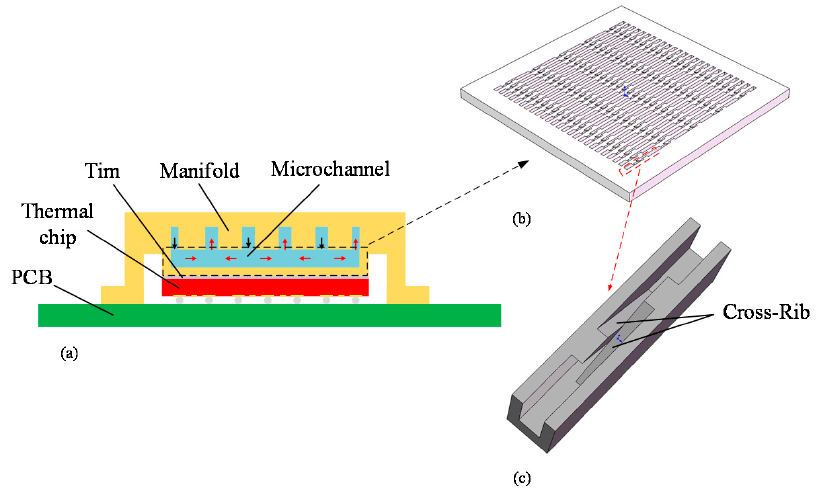
Figure 1. ( a ) Schematic diagram of the micro-channel and thermal chip; ( b ) dimensional schematic diagram of the MC-CR heat sink; ( c ) a basic unit in the MC-CR heat sink.